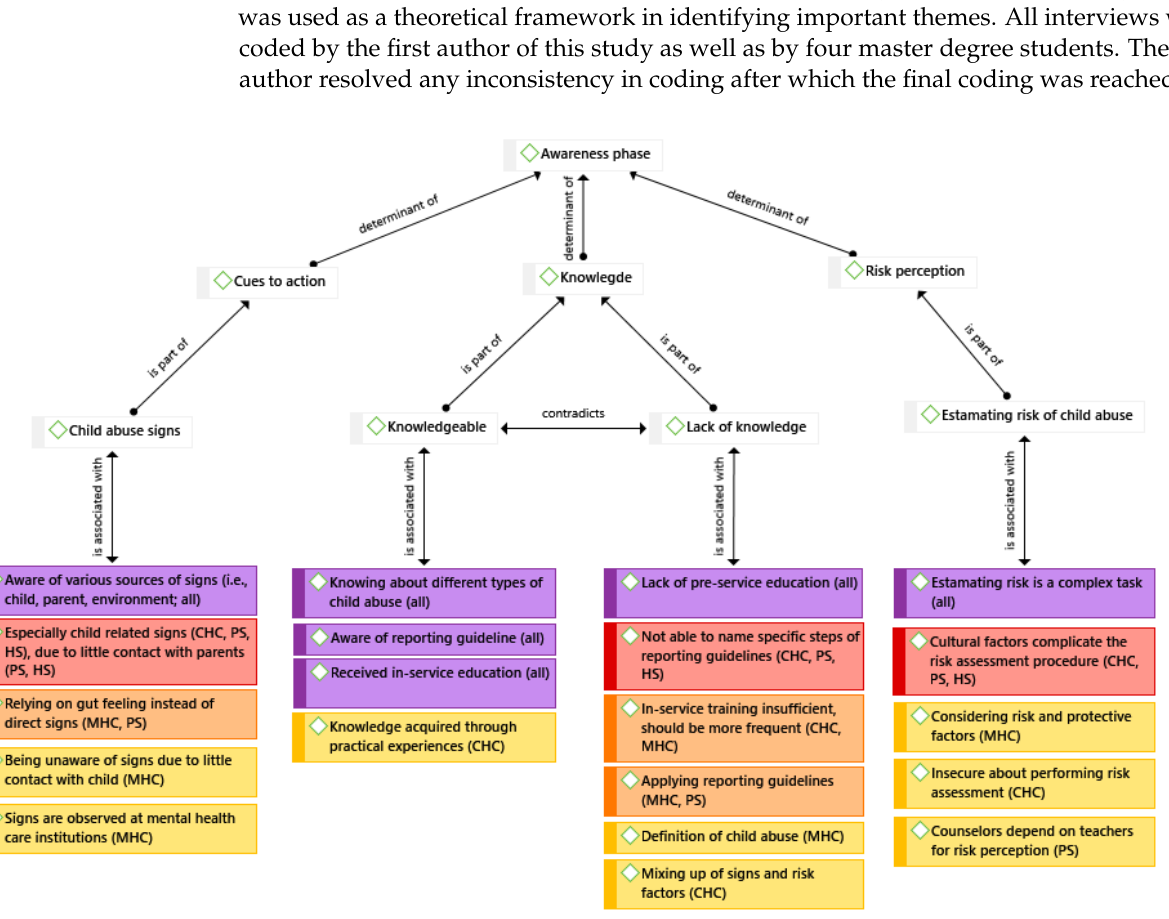
Figure 1. A concept map of the results as related to the awareness phase of the I-Change model. The labels on the second level refer to the determinants of the awareness phase, the labels on the third level refer to the key themes, and the labels on the fourth level refer to the subthemes. Subthemes with purple labels are relevant for all groups of professionals, subthemes with red labels are relevant for three groups, subthemes with orange labels for two groups, and subthemes with yellow subtheme for one group of professionals. The specific groups of professionals for which the subthemes were applicable, are presented in parentheses. CHC = child health care professionals; MHC = mental health care professionals; PS = primary school professionals; HS = high school professionals.